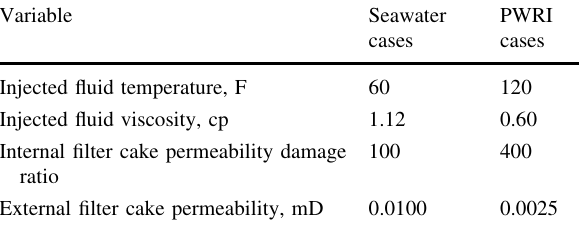
Table 4 Seawater versus PWRI case